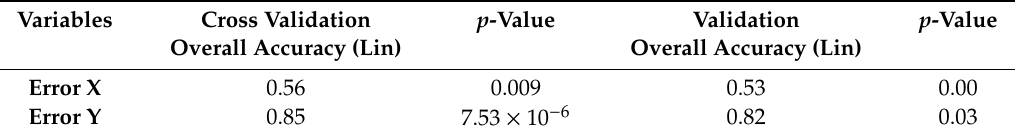
Table 10. Cross validation and validation results with the 75 GCP dataset.